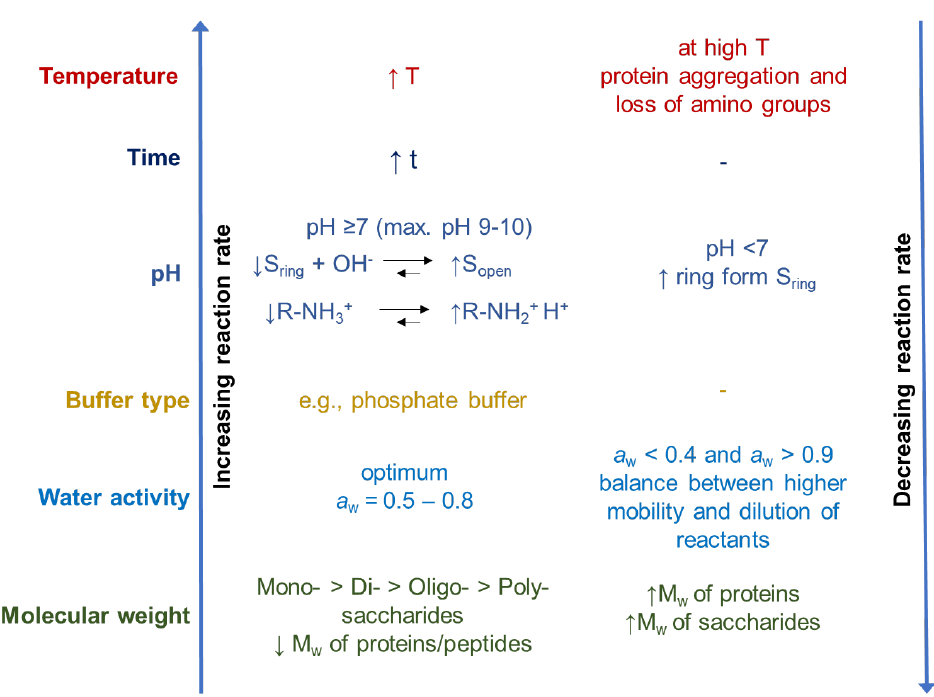
Figure 3. Schematic overview of the influence of different parameters on the reaction rate of the Maillard reaction modified from O’Mahony et al. [85] ( ↓: decrease, ↑: increase, S: sugar, Mw: molecular weight).